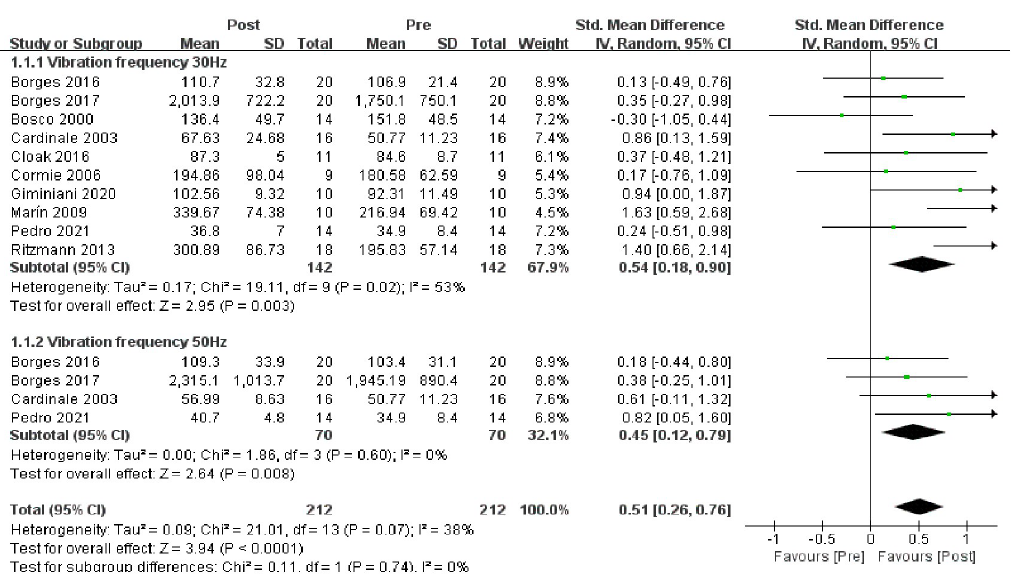
Fig 4. Meta-analysis of the acute effects of WBV on neuromuscular activation.